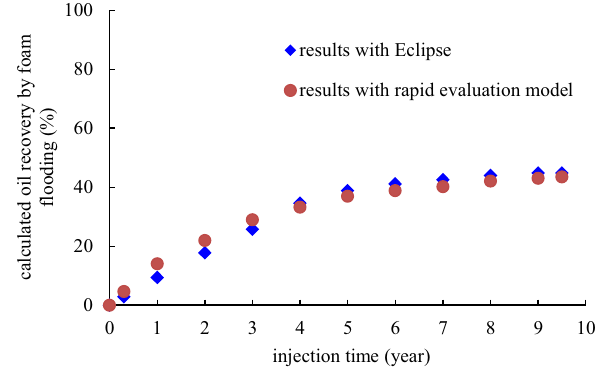
Fig. 6 Comparison on the oil recovery by foam flooding with differ- ent calculation methods